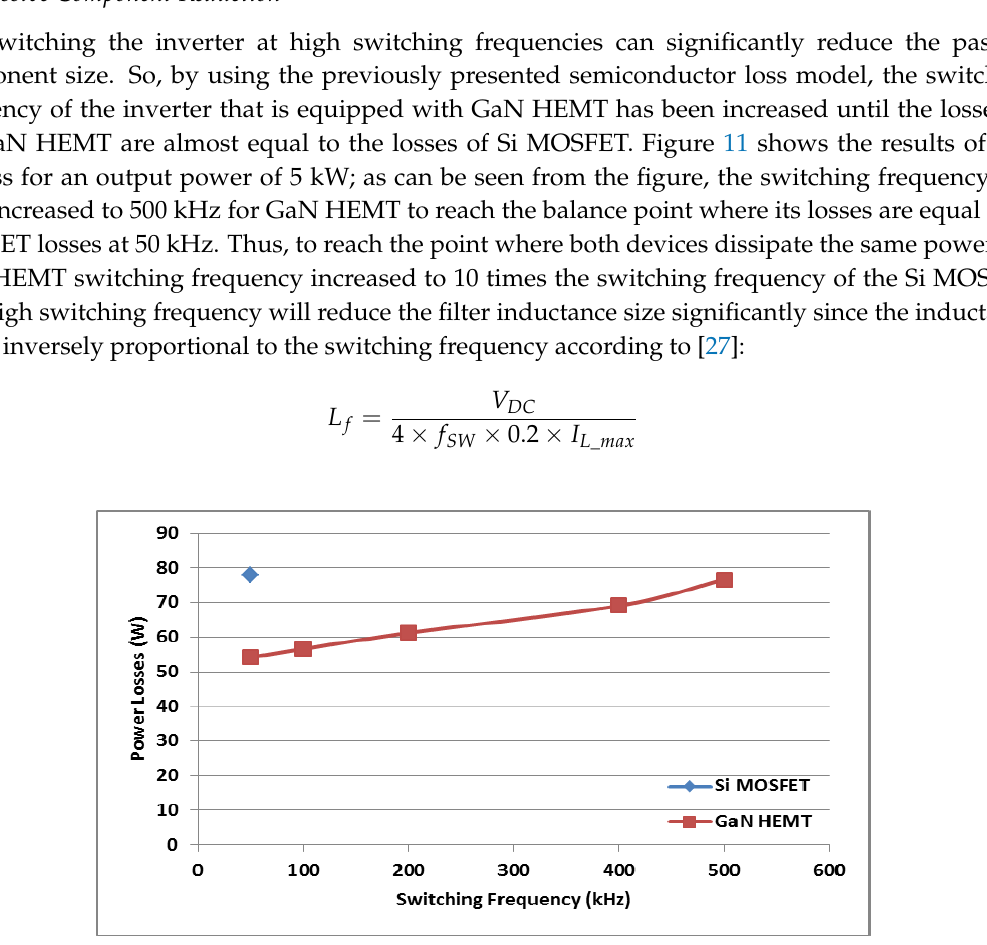
Figure 11. The balance point where GaN HEMT losses at 500 kHz is equal to Si MOSFET losses at 50